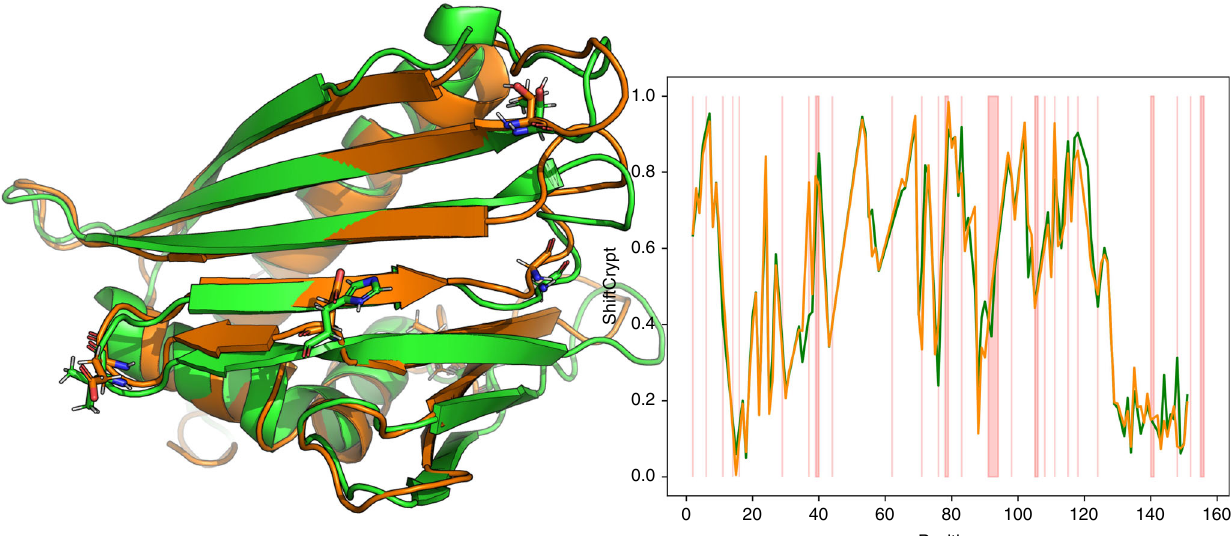
Fig. 3 Comparison of the ShiftCrypt index for two homologous proteins. The left side of the fi gure shows the superimposition of the cherry (orange) and strawberry (green) allergen structures. On the right side, we show their respective ShiftCrypt pro fi les, with the red bars highlighting amino acid mismatches in the alignment of the two